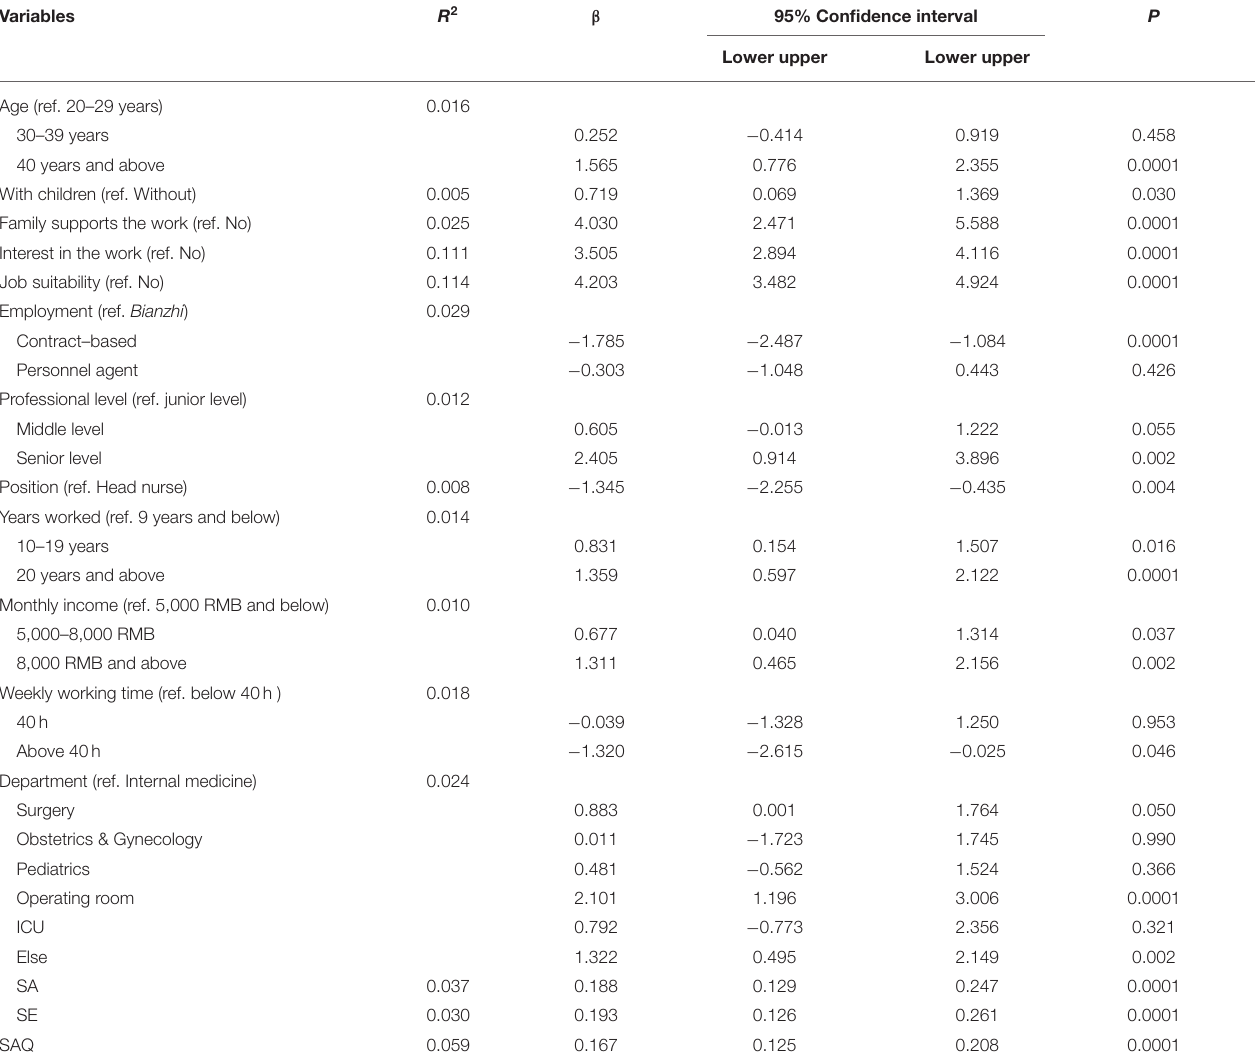
TABLE 4 | Univariate linear regression examining characters associated with intention to stay. Variables R